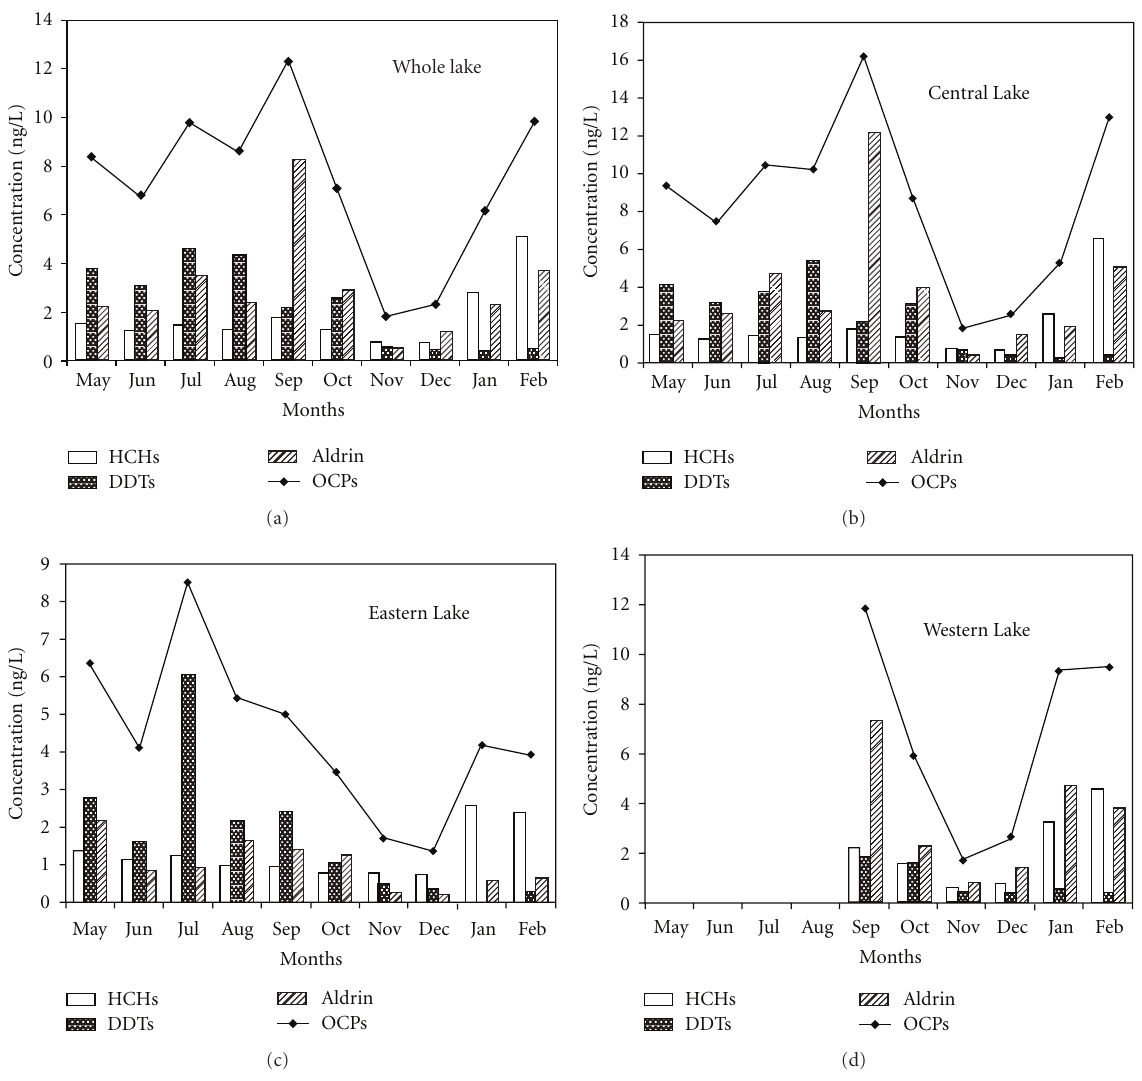
Figure 4: The temporal and spatial variation of OCPs in the water from Lake Chaohu.